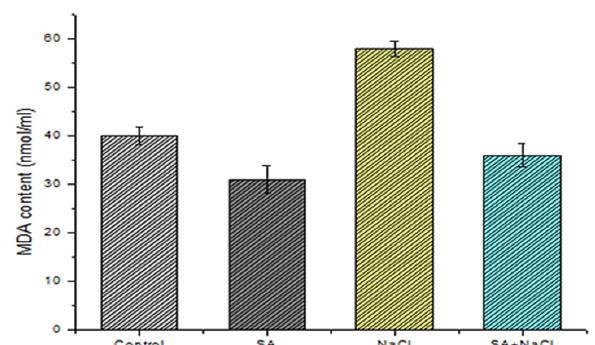
Figure 6. Leaf lipid peroxidation (MDA content): individual and combined effect of salinity and SA on leaf lipid peroxidation. X axis -treatment group; Y axis- concentration of MDA (nmol/ml) Values are expressed as mean ± SD, n=3 in each